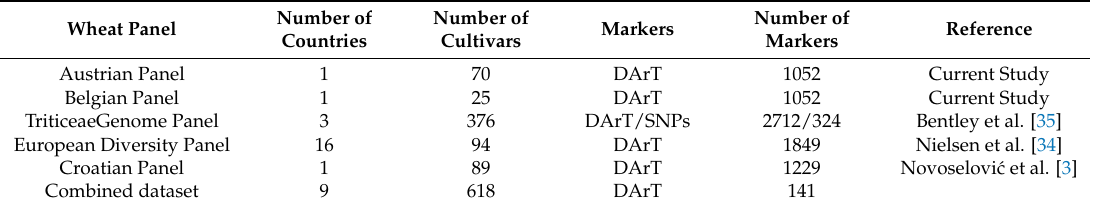
Table 1. Wheat breeding panels analysed in this study, including numbers of countries, cultivars and